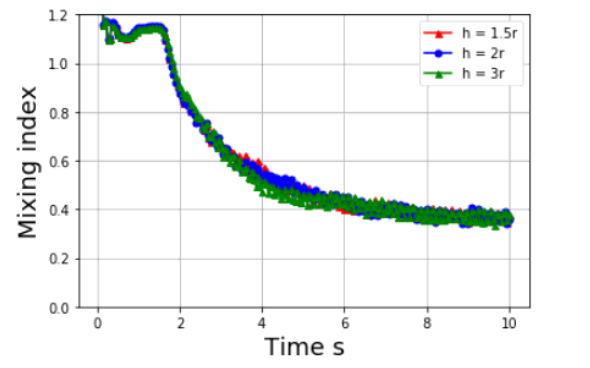
Figure 17. Mixing index at different smoothing length h